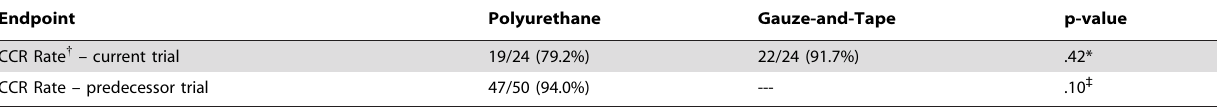
Table 2. CCR rates.